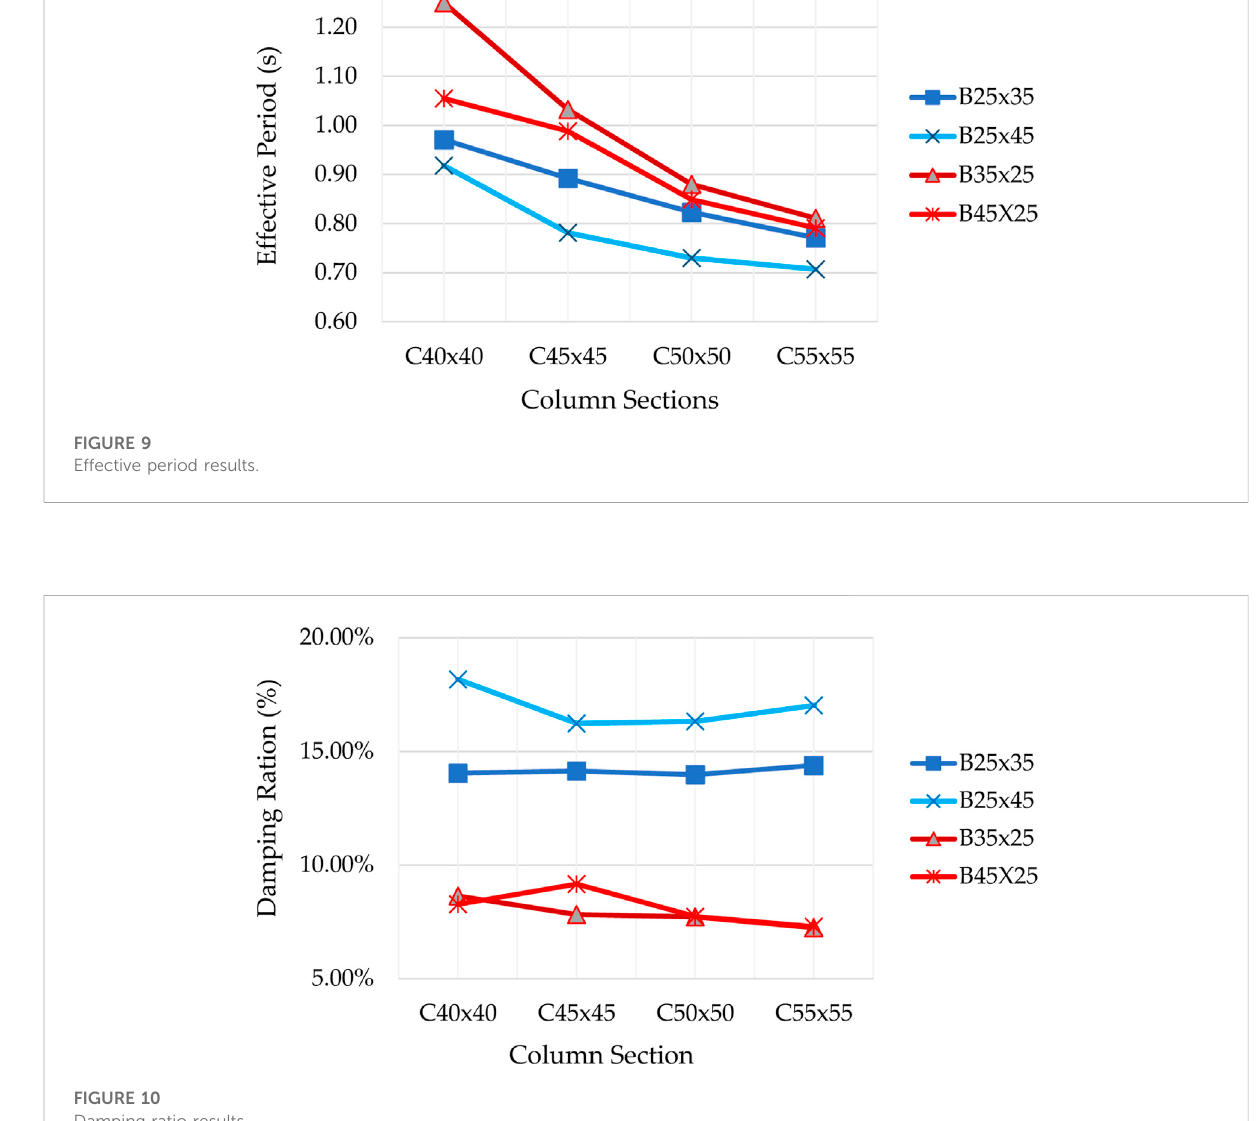
FIGURE 10 Damping ratio